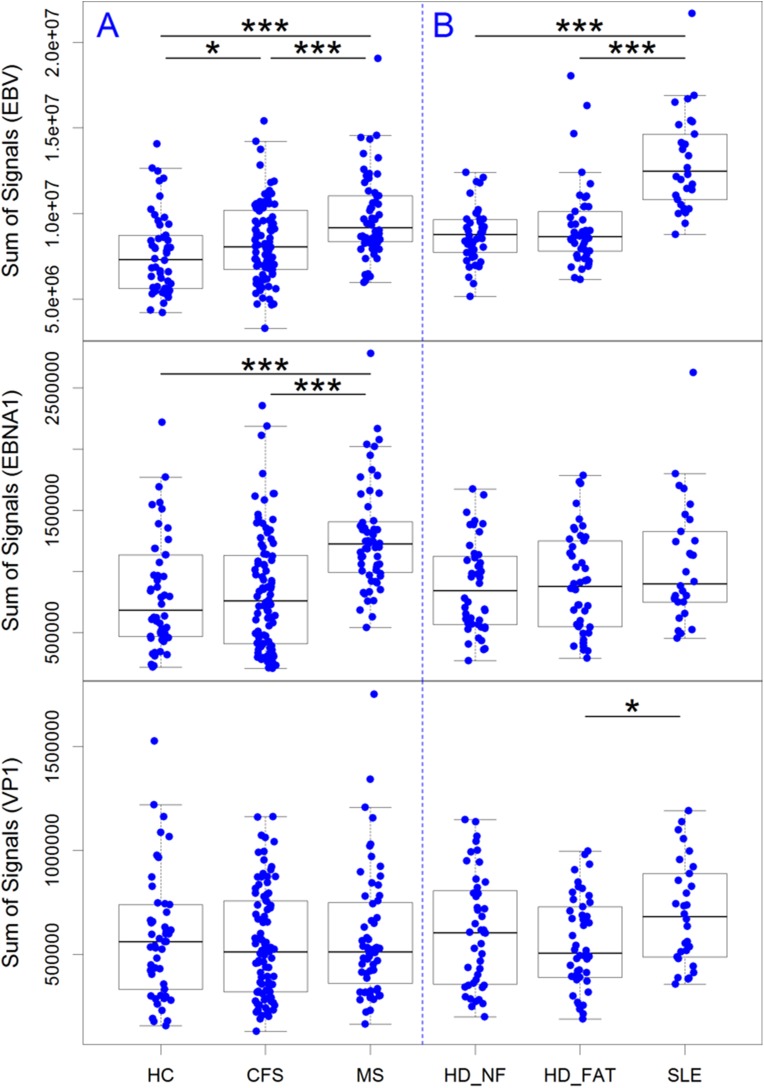
Total IgG responses against EBV, EBNA-1 and enterovirus peptides in the different cohorts.A) The signal intensity of IgG responses against all EBV peptides (upper row), EBNA-1 peptides (middle row) and enterovirus (lower row) in CFS, healthy controls and MS patients. B) Comparison of patients with SLE and Hodgkin’s lymphoma in disease remission with cancer-related fatigue (HD_NF) or without fatigue (HD_FAT) analysed in another seroarray screening experiment. Statistical analysis by Wilcoxon rank sum test with * p<0.05, *** p <0.001.